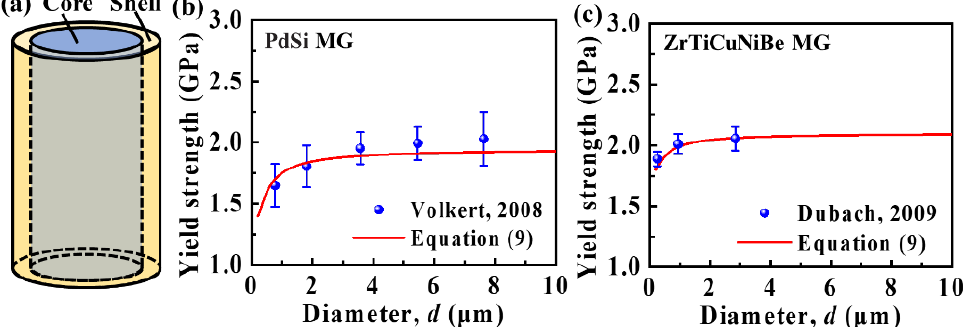
Figure 4. ( a ) Schematic illustration of the core-shell model. The outer shell is the FIB damaged layer, while the inner core is the undamaged MGs. For comparison with the core-shell model, the yield strengths are a function of the sample diameter for micron-sized MGs obtained from the experimental results of ( b ) Volkert et al. [26] and ( c ) Dubach et al.